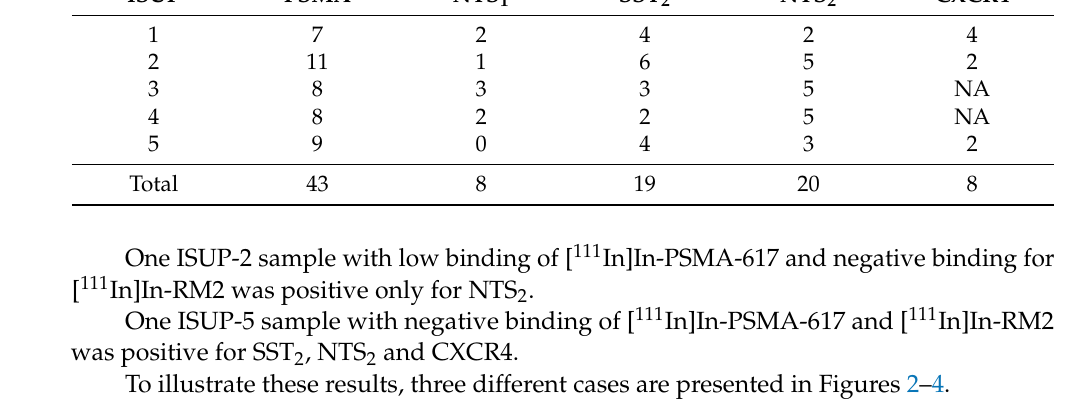
Table 5. Number of specific binding ≥ GRPR for PSMA, NTS 1 , SST 2 , NTS 2 and CXCR 4 . ISUP PSMA NTS 1 SST 2 NTS 2